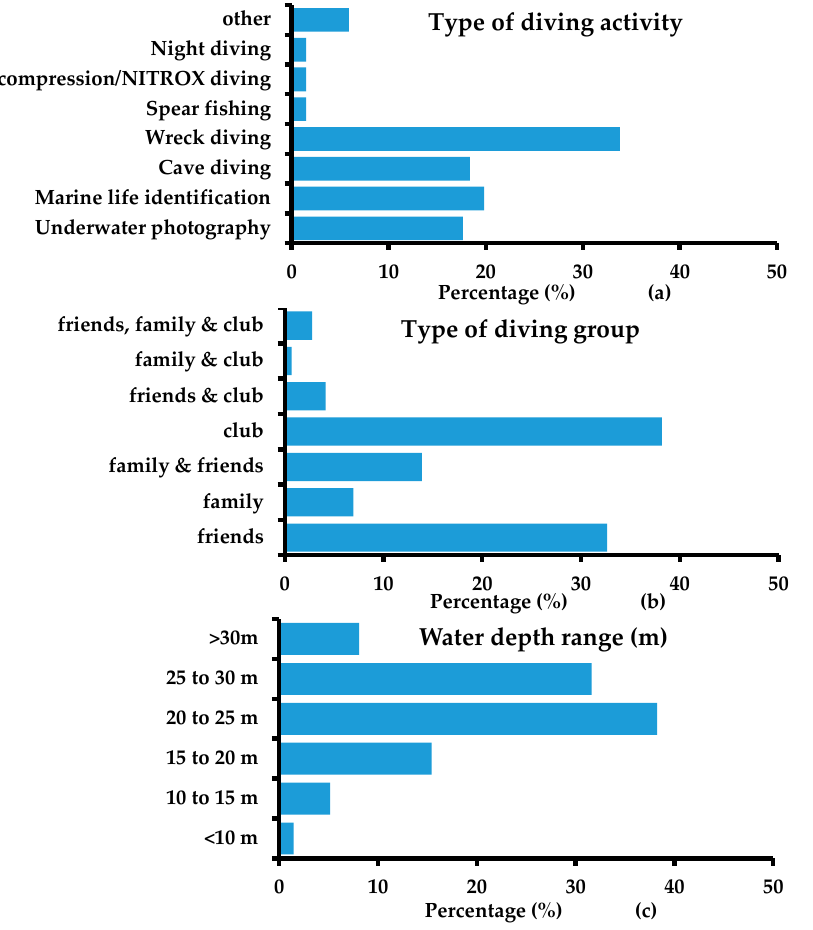
Figure 3. Diving profile of the participants: ( a ) type of diving activity they performed during the last 12 months; ( b ) type of diving group they prefer; ( c ) water depth range they prefer to dive.